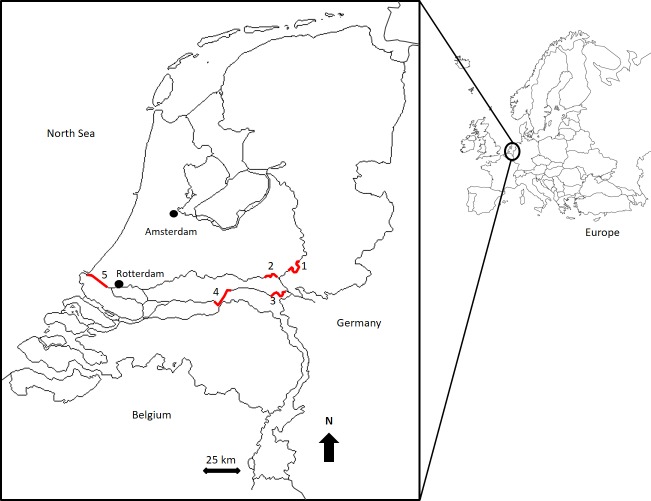
Position of five locations from the ‘Active Freshwater Fish Monitoring’ survey.These areas; Gelderse IJssel (1), Nederrijn (2), upstream Waal (3), downstream Waal (4) and Nieuwe Waterweg (5) are all within the river Rhine system.